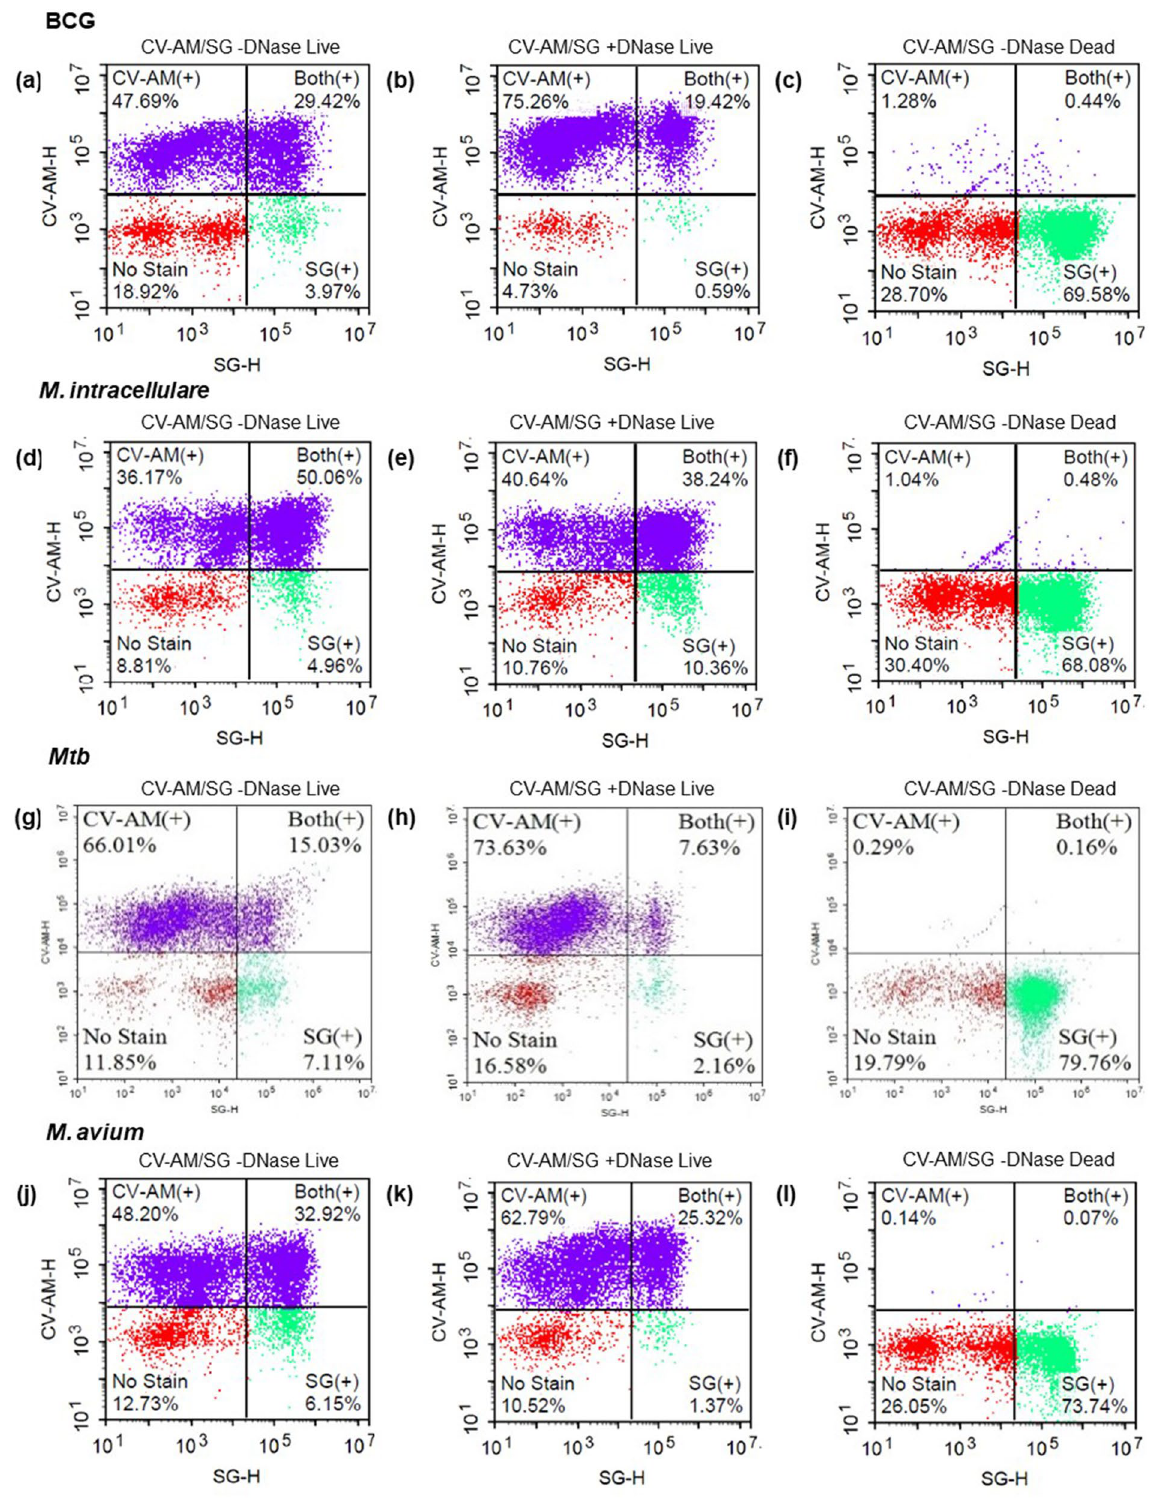
Figure 1. FACS analysis of extracellular DNA (eDNA) on BCG, M. intracellulare , Mtb, and M. avium in 7H9-ADC broth. Representative NovoCyte Flow Cytometer plots of BCG ( a , b , and c ), M. intracellulare ( d , e , and f ), Mtb ( g , h , and i ), and M. avium ( j , k , and l ) stained by calcein violet with an acetoxy-methyl ester group (CV-AM) typical of live cells and SYTOX Green (SG) stains DNA, respectively. Bacteria were treated with Benzonase Nuclease I ( b , e , h , and k ) or heated at 95 °C for 5 min ( c , f , i , and l ) before